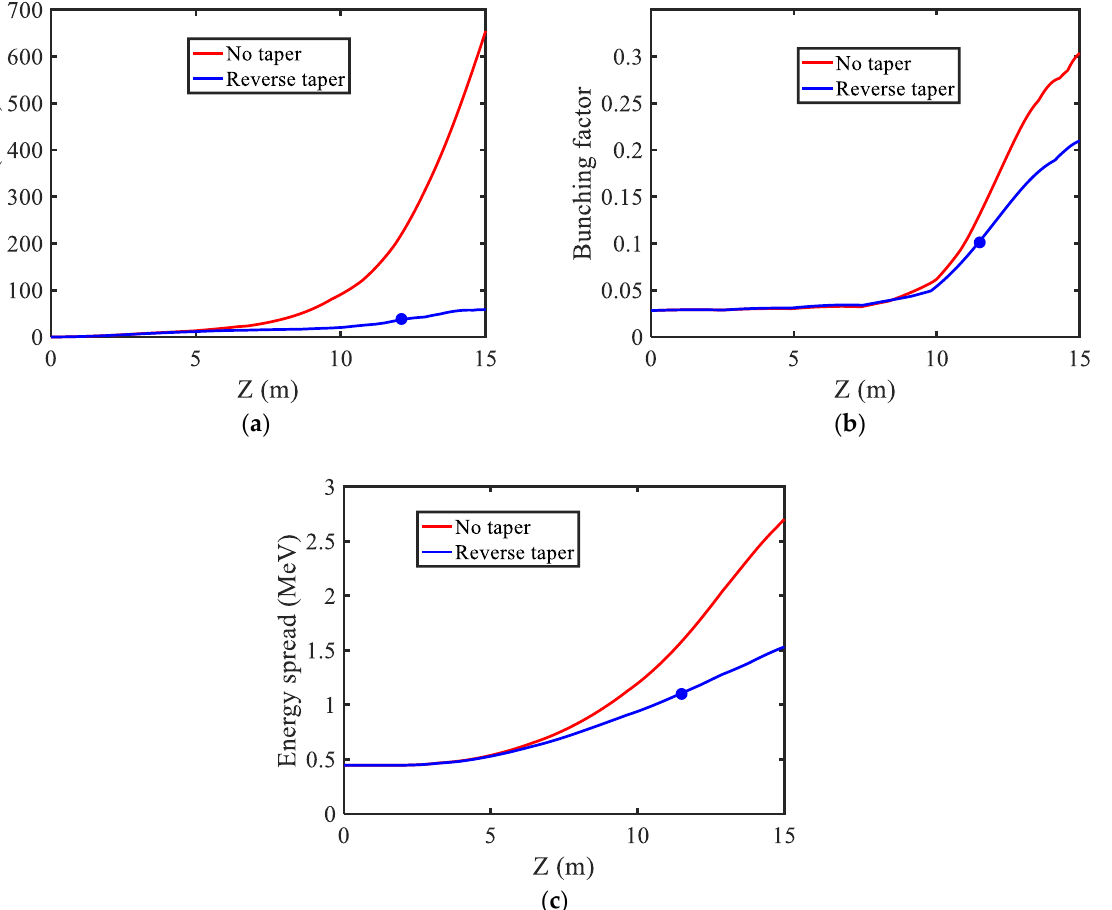
Figure 5. The evolutions of FEL peak power ( a ), bunching factor at the 225th harmonic of the seed ( b ) and energy spread ( c ). The red lines represent the case without taper and the blue lines represent the case with reverse taper. The electron beam is extracted from the reverse tapered undulator at the blue point (12.3 m).